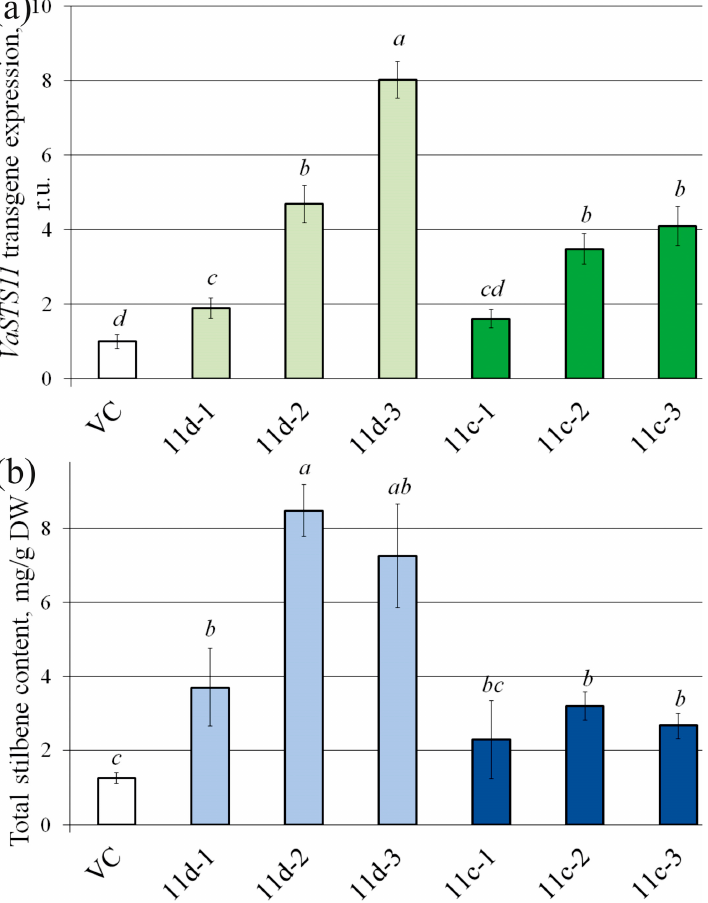
Figure 6. Quantification the VaSTS11 transgene mRNAs performed by quantitative RT-PCR ( a ) and quantification of total stilbene content performed by HPLC ( b ) in the transgenic cell cultures of Vitis amurensis . VC—the control V. amurensis cell line transformed with the vector harboring only the npt II selective marker; 11d-1, 11d-2, and 11d-3— V. amurensis cell lines independently transformed with VaSTS11d ; 11c-1, 11c-2, and 11c-3— V. amurensis cell lines independently transformed with VaSTS11c ; r.u.—related units calculated as described in [32]; fluorescence in VC is indicated as “1”. The data are presented as mean ± SE (two independent experiments with eight technical replicates for quantitative RT-PCR and three independent experiments with two technical replicates). Means followed by the same letter were not different using Student’s t test, where p < 0.05 was considered to be statistically signi fi cant. Table 2. Biomass and stilbene accumulation in the cell lines of Vitis amurensis overexpressing the VaSTS11c or VaSTS11d gene transcripts. Means followed by the same le tt er were not di ff erent using Student’s t test, where p < 0.05 was considered to be statistically signi fi cant.